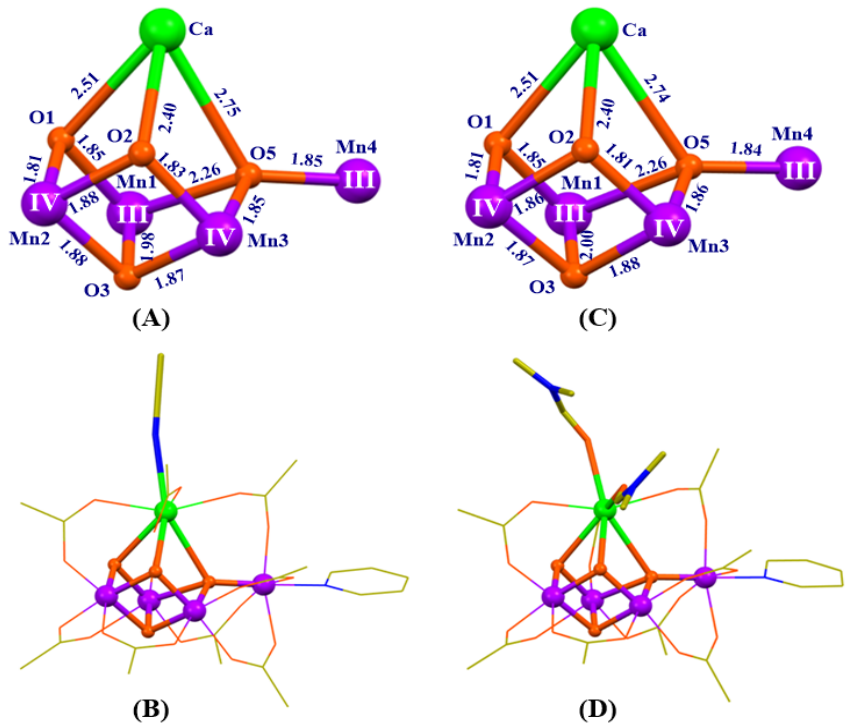
Figure 13. Crystal structures of two new artificial Mn 4 CaO 4 -complexes with an exchangeable solvent, acetonitrile ( A , B ) and DMF ( C , D ) on the calcium [58]. Mn, Ca, O, N, and C are shown in purple, green, orange, blue, and yellow, respectively. Distances are given in Å. The oxidation states of four manganese ions are obtained by the BVS calculation. For clarity, all the methyl groups in pivalic groups and hydrogen atoms are omitted.